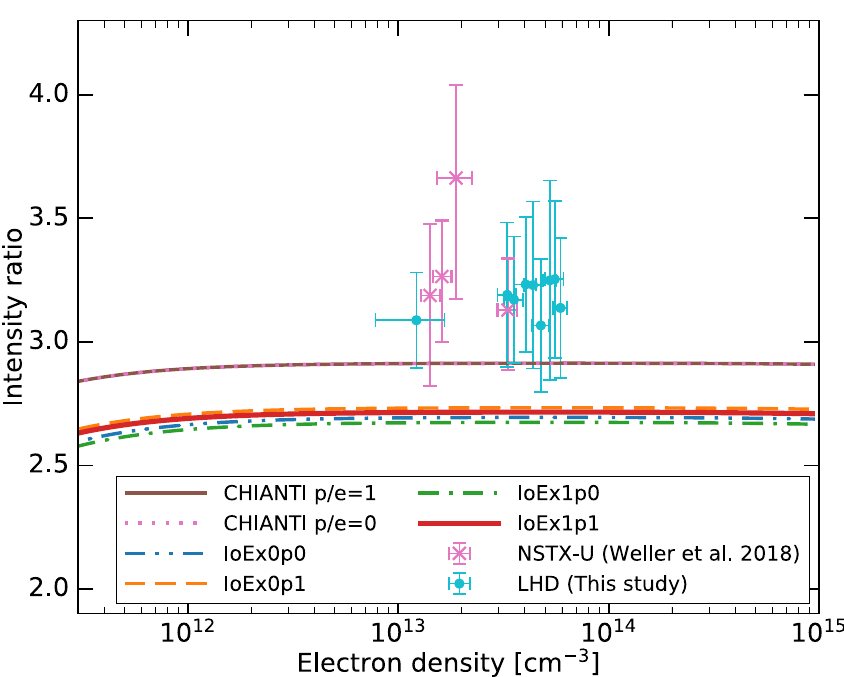
Figure 11. Electron density dependence of Fe XIV 264 Å/274 Å intensity ratio from laboratory experimental data. Pink crosses show results measured using NSTX-U [17]. Sky-blue filled circles show measured ratios with LHD. Red line represents result of our CR-model with plasma temperature T e = T p = 168 eV, which includes both the proton-impact excitation and ionization process to the excited states of a Mg-like iron ion. For comparison, we show results calculated using CHIANTI ver. 9 model [12,13] with electron/proton density ratio = 1 with brown solid line and with electron/proton density ratio = 0 in pink dotted